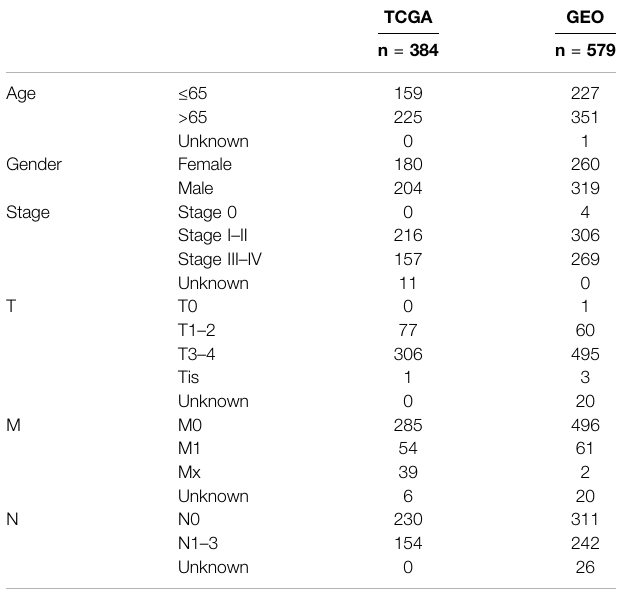
TABLE 2 | Clinical information of COAD patients from TCGA and